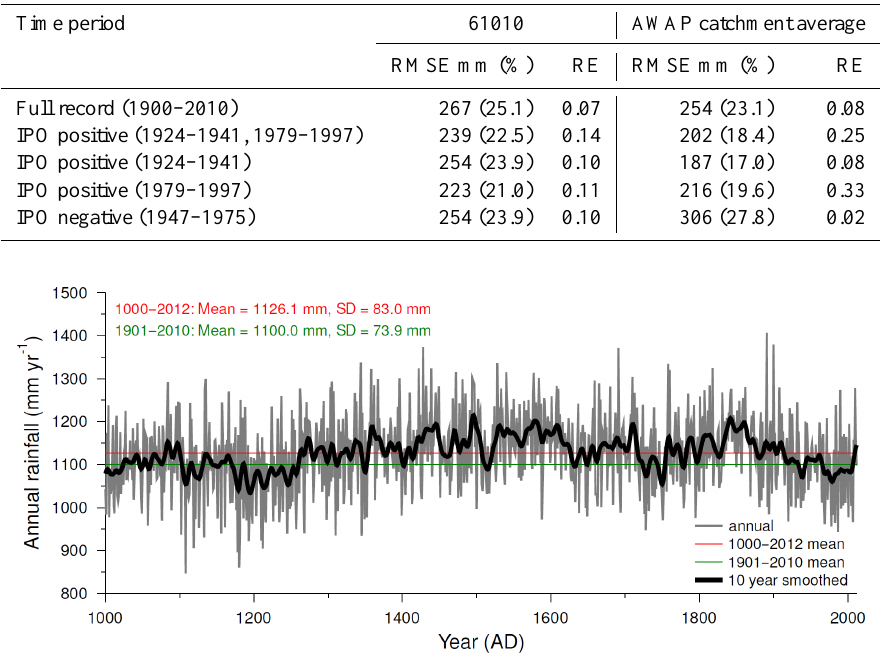
Figure 5. WR catchment rainfall reconstruction (grey line), 10-year Gaussian smooth (bold black line) mean of the rainfall reconstruction for 1000–2012 period (red line) and 1900–2010 period (green